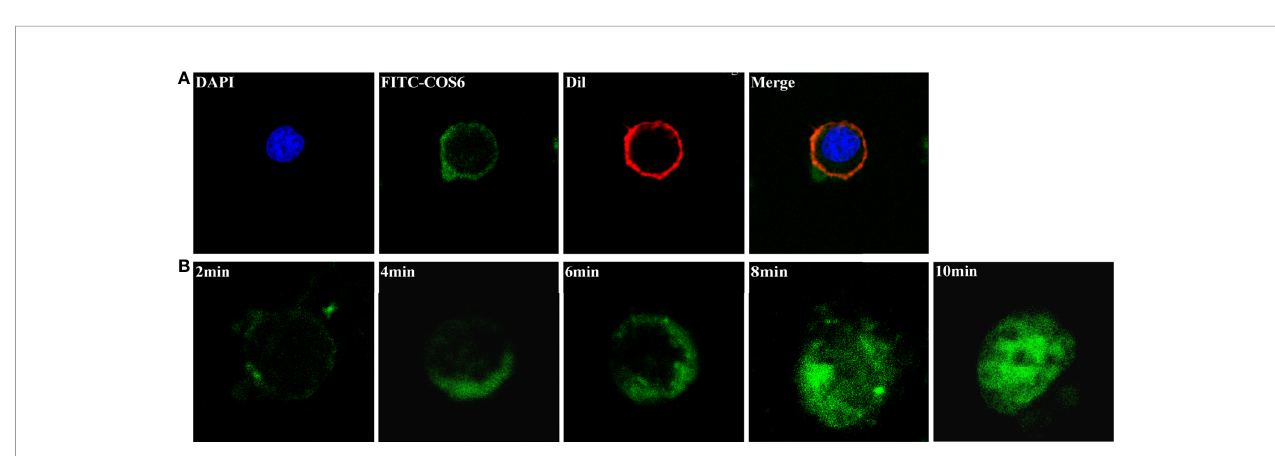
FIGURE 3 | Internalization of chitooligosaccharide hexamer (COS6) inmacrophages. (A) Here, 0.05 mM fl uorescein isothiocyanate (FITC)-COS6 isinternalized into macrophages byincubating for 10 min at 4°C, then the cellmembrane was stainedwith 1,1 ’ -dioctadecyl-3,3,3 ’ ,3 ’ -tetramethylindocarbocyanine perchlorate (DiI) and the cell nucleuswas stainedwith 4 ′ ,6-diamidino-2-phenylindole (DAPI). (B) The internalization ofFITC-COS6 at different times (2, 4, 6, 8, and10 min). Cells (1 × 10 6 – 1 × 10 7 ) were incubated with 0.05 mMFITC-COS6 at 28°C andexamined bya confocal microscope. All the experiments were repeated at least three times. Scalebar:5 m m.